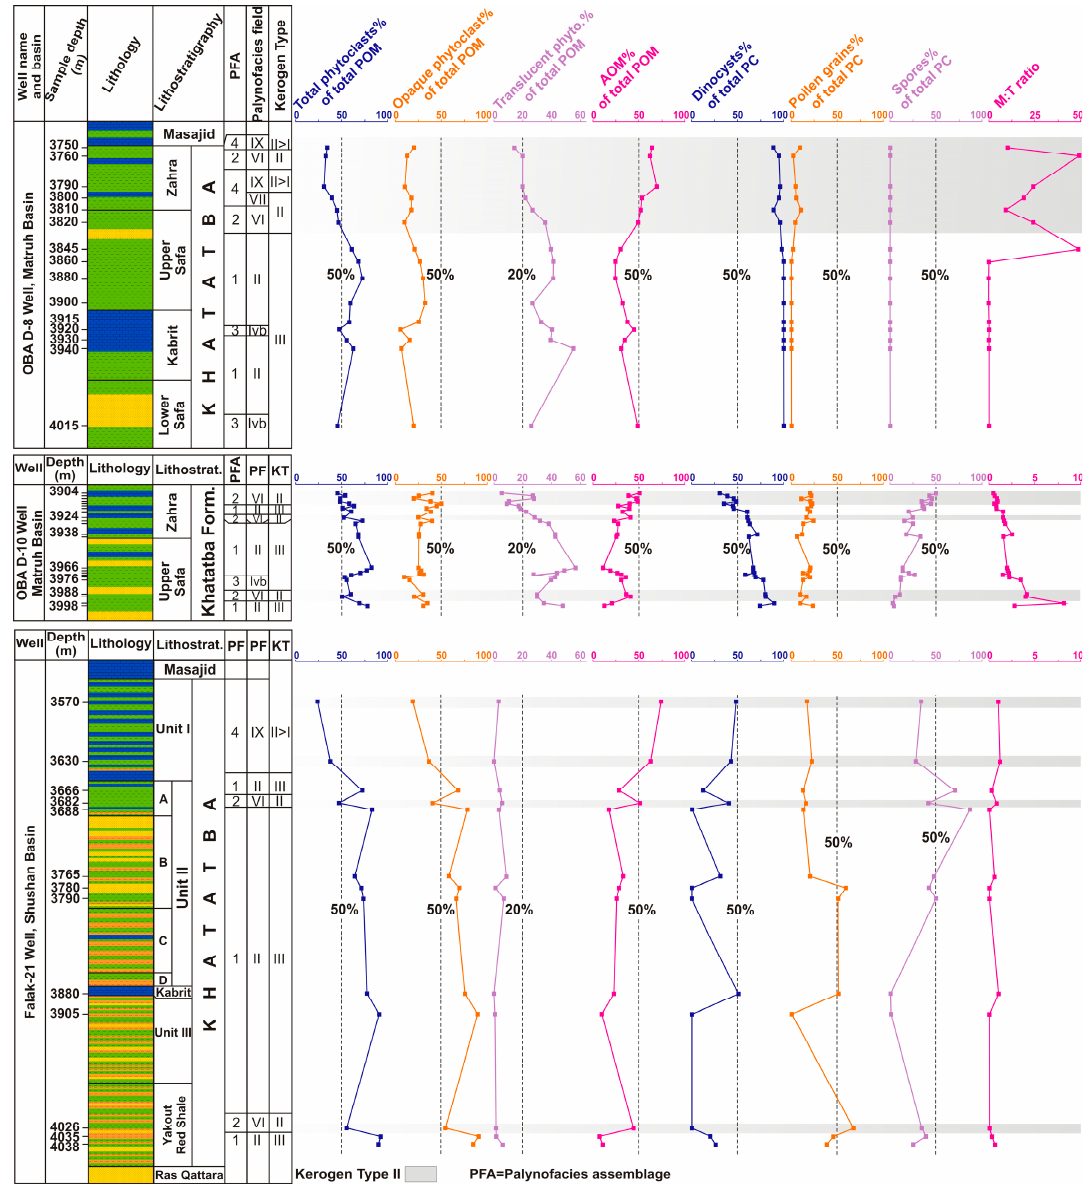
Figure 7. Stratigraphic distribution chart of kerogen parameters, palynomorph composition, and M:T ratios of the Khatatba Formation from the OBA D-8 and OBA D-10 wells in the Matruh Basin and the Falak-21 well in the Shushan Basin.